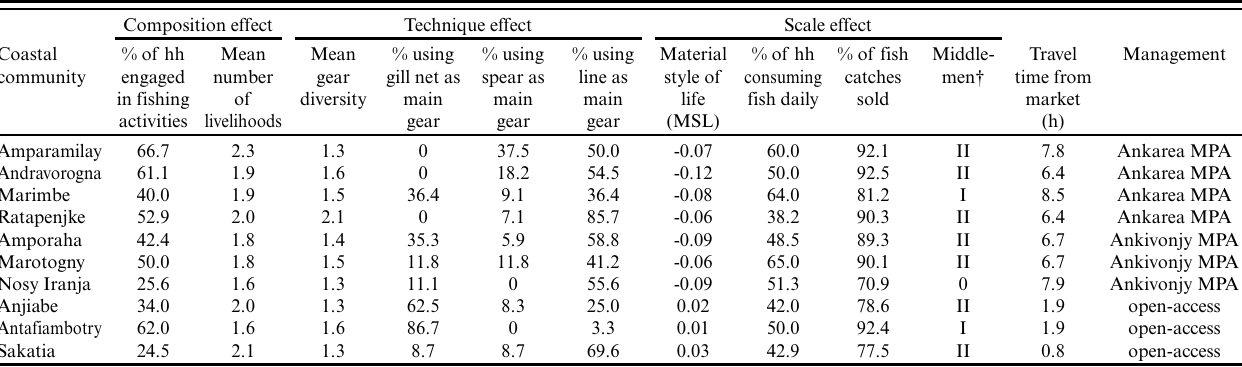
Table 4 . Descriptive statistics of the socioeconomic indicators measured for the 10 coastal communities. Travel time from the nearest market and the presence of management actions are also